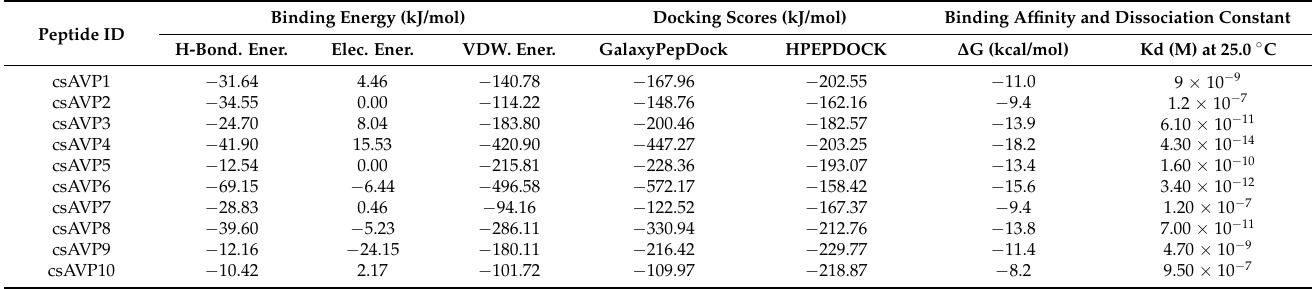
Table 6. Calculated binding energy, docking scores, binding affinity ( ∆ G), and dissociation constant (Kd) from molecular docking of ten candidate peptides (csAVP1 to csAVP10) to SARS-CoV-2 3CLpro by PROGIDY and PIMA web server. Molecular docking scores, H-bond, electrostatic, and van der Waals energy (H-bond Ener., Elec. Ener., and VDW. Ener.) are presented in kJ/mol